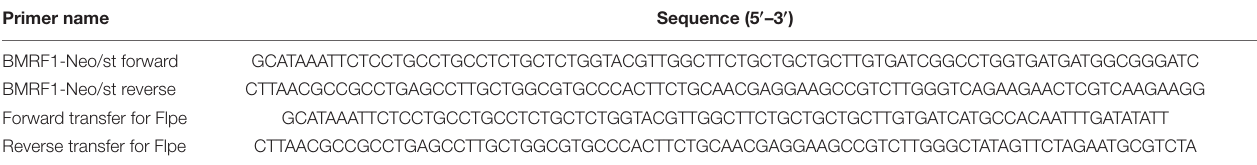
TABLE 4 | Oligonucleotide primers used for generation of recombinant